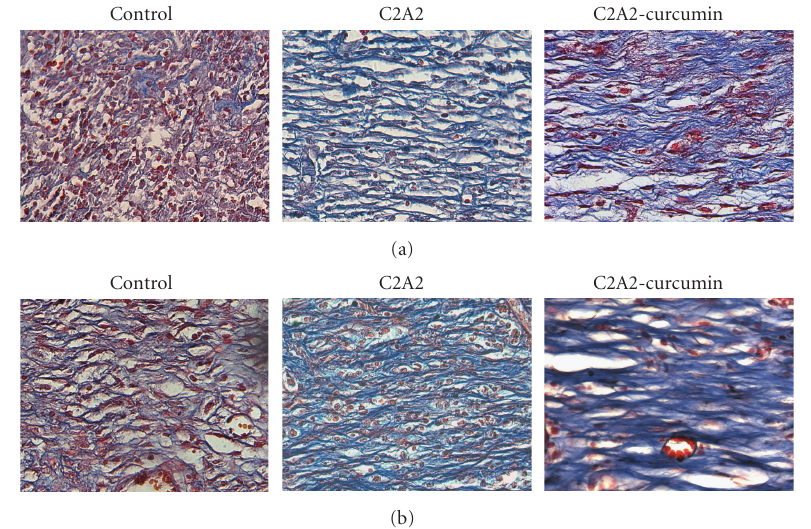
Figure 9: Masson’s Trichrome staining for collagen: (a) eight-day postwounding; (b) twelve-day postwounding (40 ×